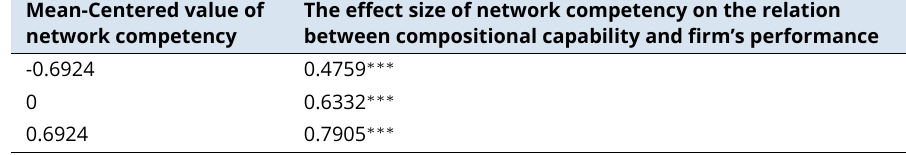
Effect size of network competency on the relation between compositional capability and firm performance